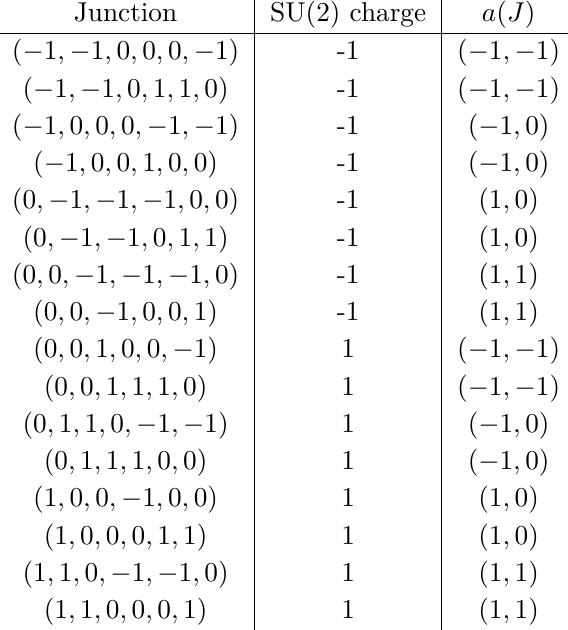
Table 7 . The 16 junctions near the point of enhancement III → I ∗ charge of the state under the Cartan U(1) of SU(2) . a ( J ) is computed with respect to the first three 7-branes which are the gauge